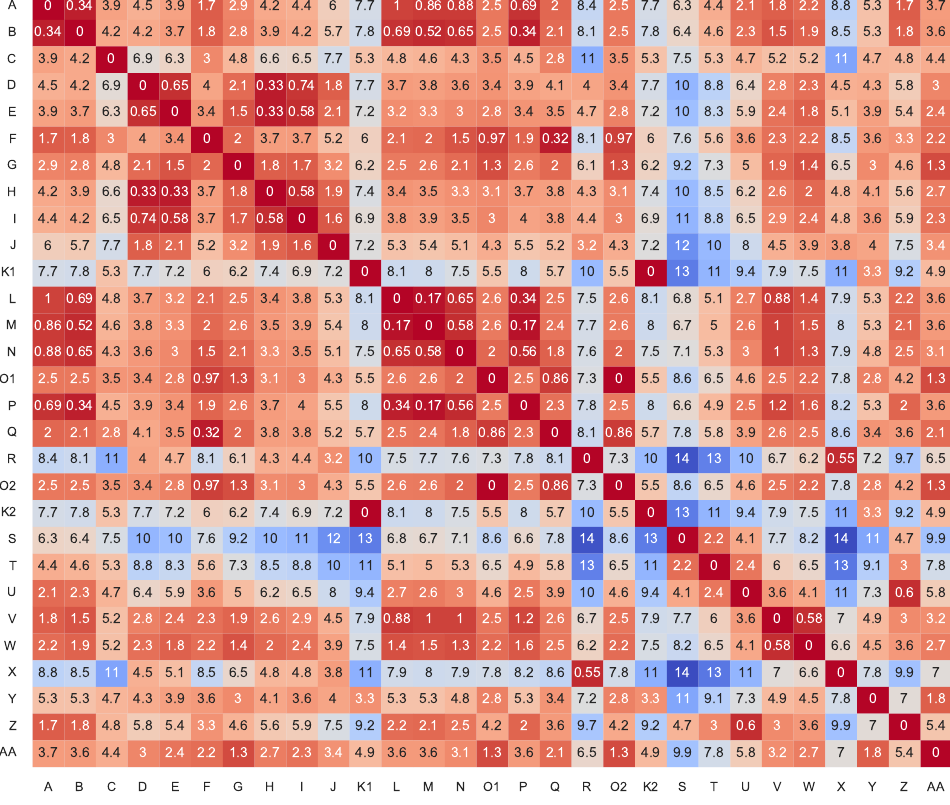
Figure A7. Distance matrix of wind speed of considered wind farms. Shown are pairwise dis- tances in 100 km, each calculated from the two positions from the respective sites in the ERA5 grid. For clearer representation, the matrix elements are colored from dark red (same position) to dark